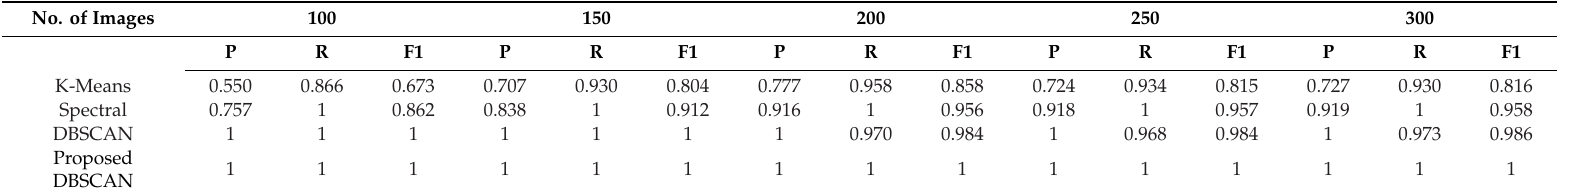
Table 5. Precision (P), Recall (R), F1-measure (F1) on 25 randomly selected identities from Arabian faces